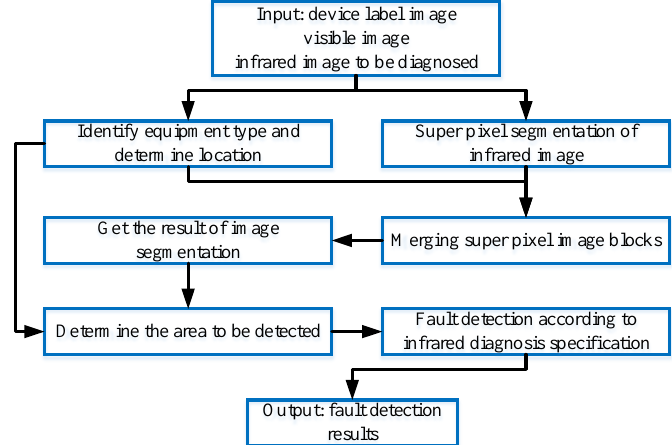
Figure 4. Flow chart of infrared image fault diagnosis.